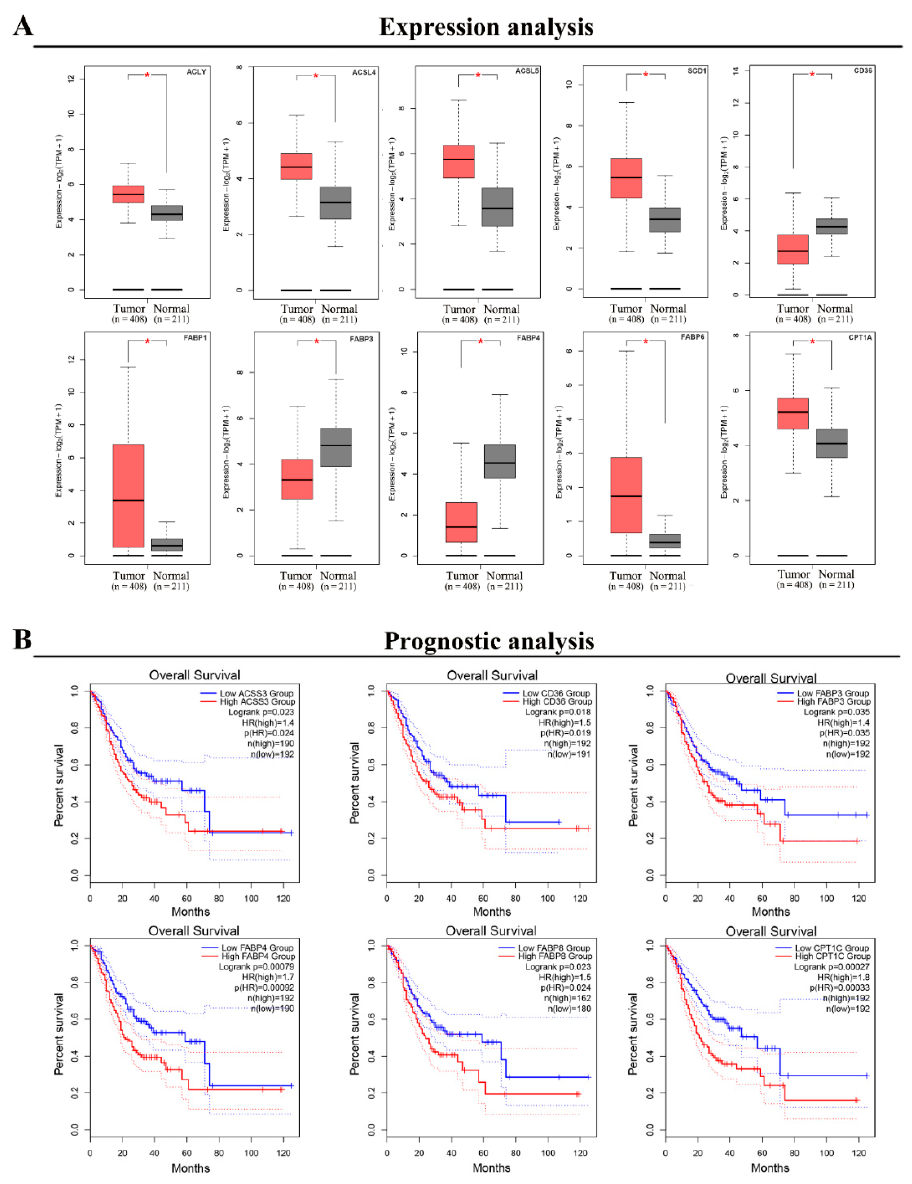
Figure 2. ( A ) Expression of fatty acid metabolism-related genes in GC and paracancerous tissues. ( B ) Correlation between the expression levels of fatty acid metabolism-related genes and the prognosis of GC patients. Red asterisk: p < 0.05 .